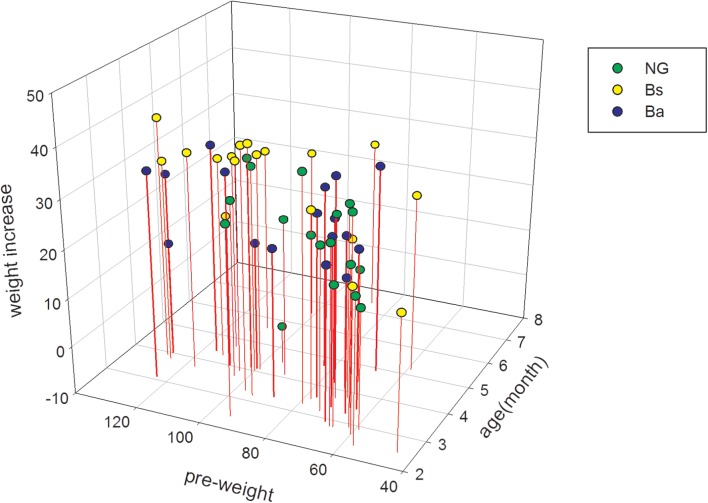
The age specific weight increasing among different groups pre- and post-intervention.